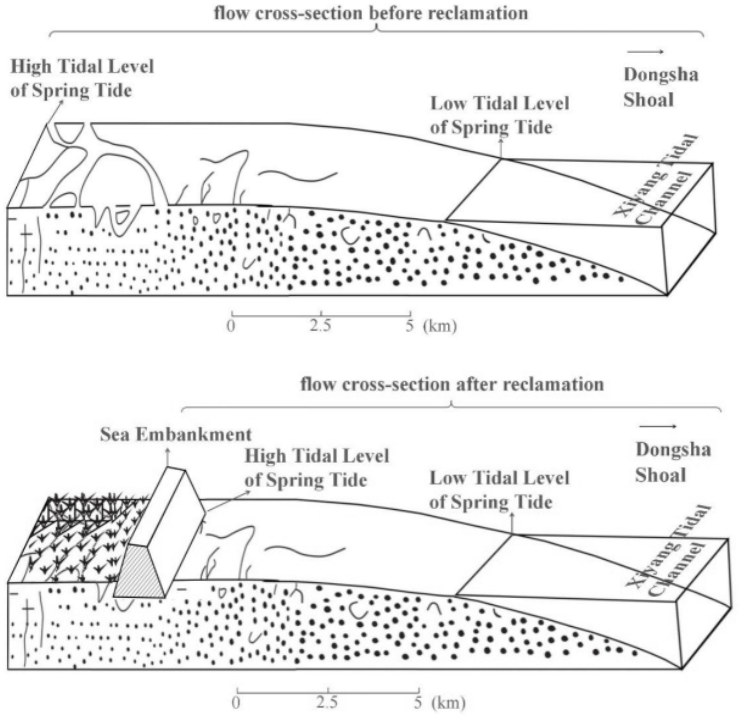
Figure 14. Representation of the water flow cross sections of the Xiyang tidal channel before and after reclamation.